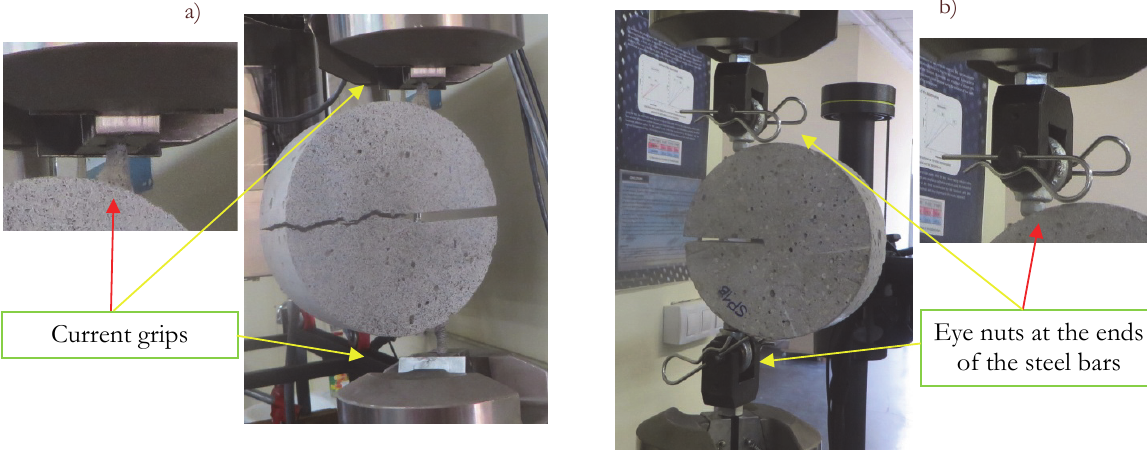
Figure 3: Attachment of an experimental specimen to a servo-hydraulic test machine. According to the schematic diagram above: a) current set-up - attachment without torsion; b) set-up with eye nuts in the ends of the steel bars.